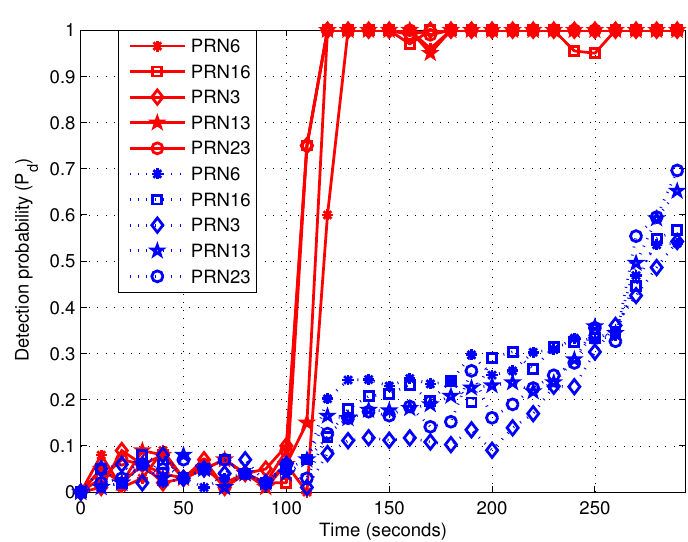
Figure 9. The relationship between detection probability and time length. The red solid and blue dashed curves are separately corresponding to the proposed algorithm and the ratio method. The false alarm probability was set to 0.1.